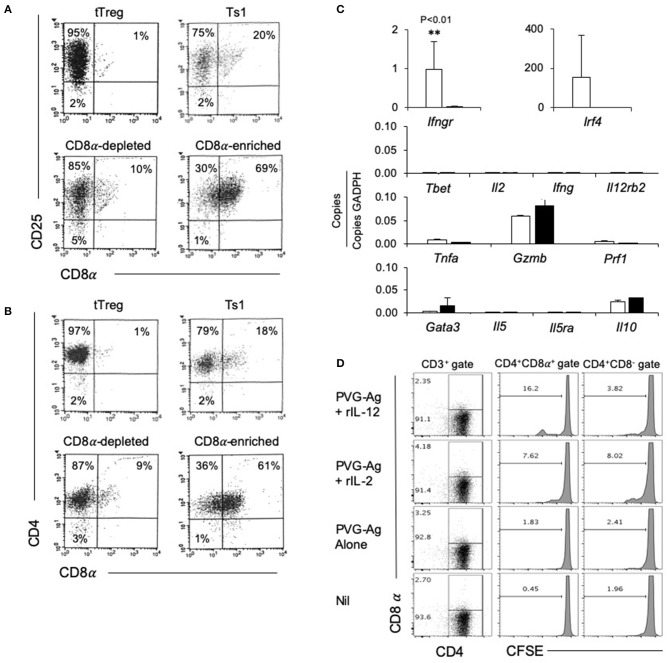
Studies on CD8α-enriched and CD8α-depleted populations prepared from Ts1 cells activated by 4 d culture of CD4+CD8−CD25+T cells from naïve DA rats with rIL-2 and PVG. Freshly isolated CD4+CD25+T cells (tTreg) from naïve DA rats compared to those cultured with rIL-2 and PVG alloantigen before and after fractionation into CD8α-depleted and CD8α-enriched populations. (A,B) FACS profiles of fresh naïve tTreg compared to unfractionated Ts1 cells and the CD8α-enriched and CD8α-depleted populations. All cultured populations had about 95% CD25+ cells (A) and >95% CD4+cells (B). Representative data from one of three experiments. (C) RT-PCR of cytokines, cytokine receptors and transcription factors: comparison of expression in CD8α-enriched and CD8α-depleted fractions of Ts1 cells. The CD8α-enriched population (White bars) had significantly higher expression of Ifngr (p < 0.01) and more Ifr4 compared to CD8α-depleted fraction (black bars) of Ts1 cells. There was no difference in expression of Type-1 associated molecules Tbet, Il-2, Ifng, Il12rb2 or cytotoxic cells molecules Gzmb and Prf1. There was also no difference in Type-2 associated molecules gata3, Il5, Il5ra, and Il10. Representative data from one of two experiments. (D) Comparison of proliferation of CD8α+ and CD8α− cells within Ts1 population further cultured with rIL-2 or rIL-12. Ts1 cells were prepared from naïve tTreg by culturing them with PVG alloantigen and IL-2 for 4 days. Unfractionated Ts1 cells were subsequently cultured either alone, with PVG alloantigen only, and with PVG alloantigen and either rIL-2 or rIL-12 for 3 days. Cells were stained with CD4/CD8α/CD3 antibody and CFSE dilution was assessed on a FACS Canto II to assess proliferation by gating on CD8α+ and CD8α− populations within T cells (CD3+ Gate). rIL-12 induced more proliferation in the CD8α+ cells than in CD8α− cells suggesting these cells expressed IL-12R and responded to this cytokine. Proliferation with rIL-2 was similar in both populations.